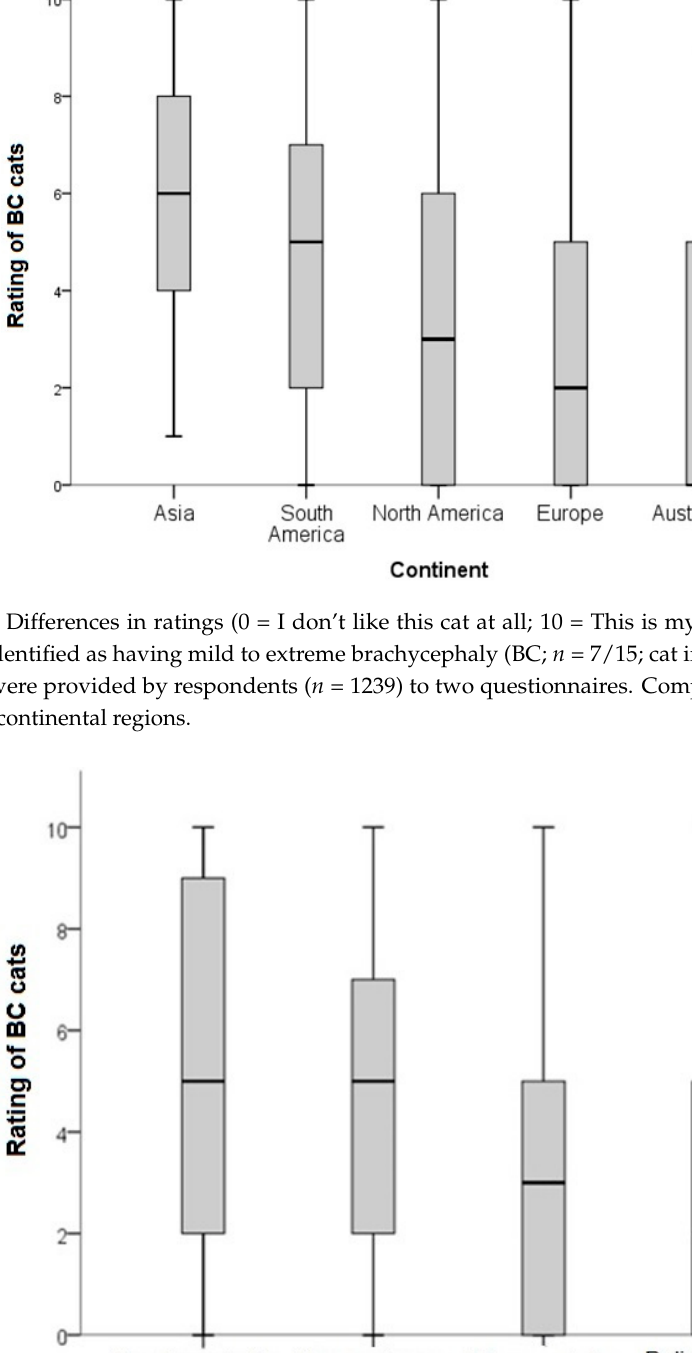
Figure 3. Differences in ratings (0 = I don’t like this cat at all; 10 = This is my favorite kind of cat) for cats identified as having mild to extreme brachycephaly (BC; n = 7/15; cat images as per Table 1). Ratings were provided by respondents ( n = 1239) to two questionnaires. Comparisons are between different continental regions.